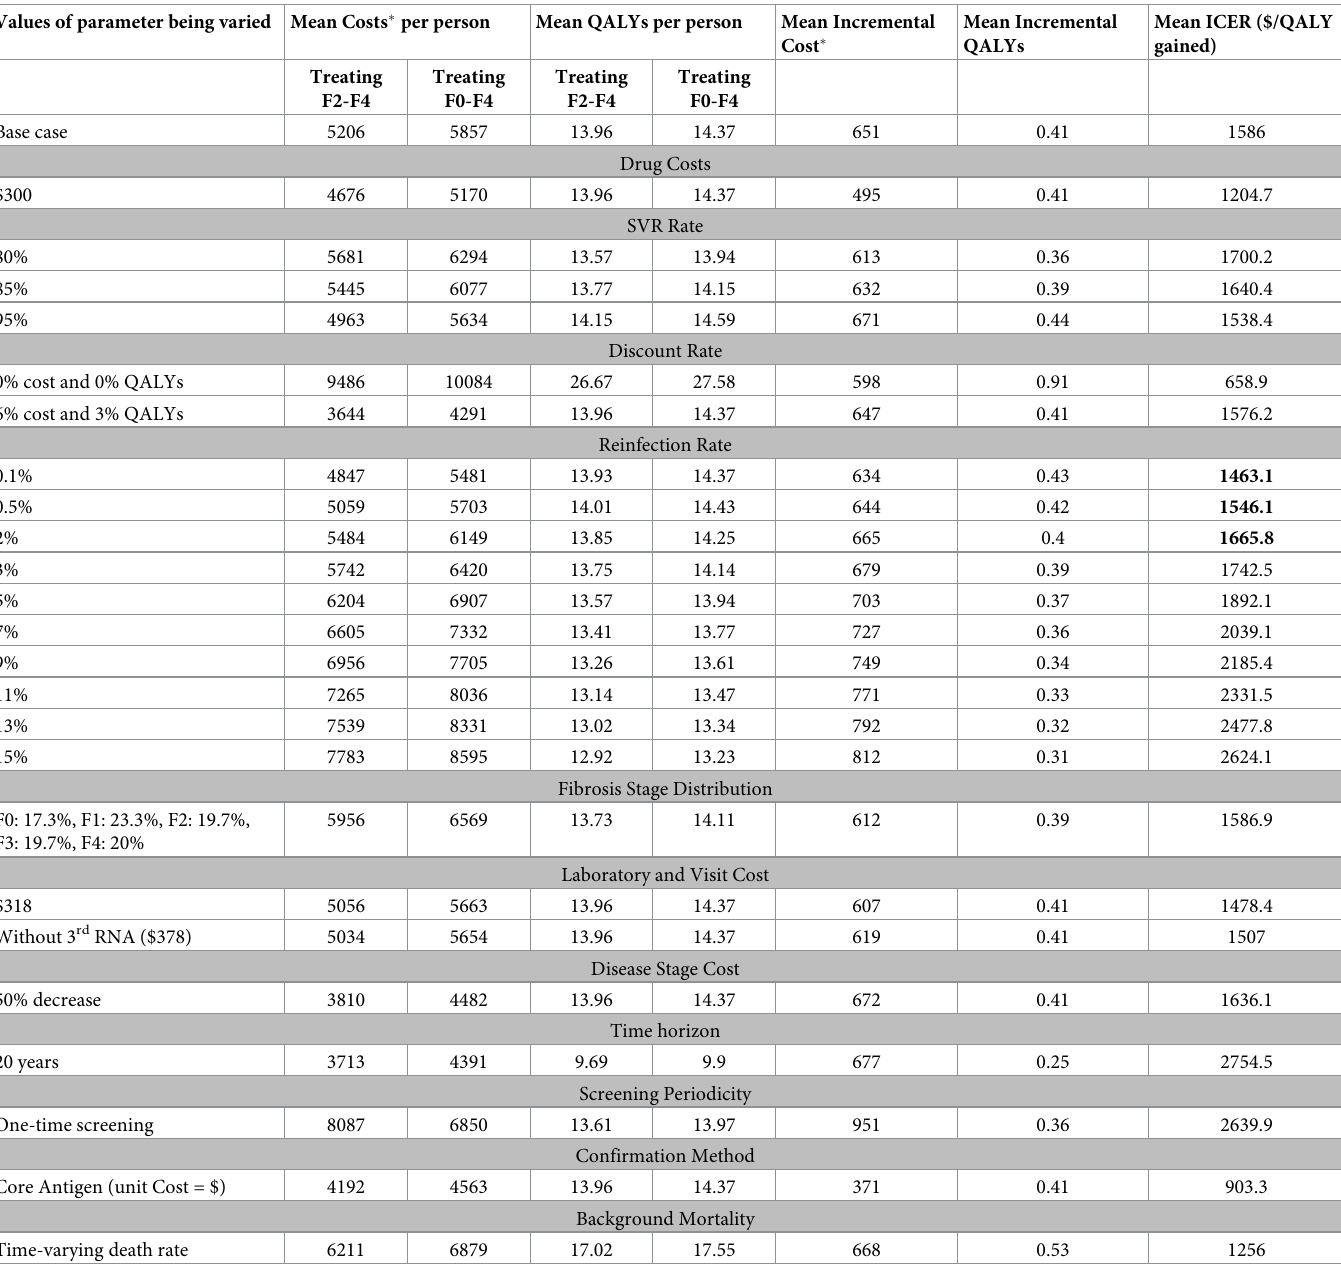
Table 2. Sensitivity analyses of cost-effectiveness results treating all diagnosed individuals (F0-F4 fibrosis) compared to targeting those with moderate-severe liver disease (F2-F4). ICER: Incremental cost-effectiveness ratio. QALY: quality adjusted life year. SVR: Sustained viral response. Values of parameter being varied Mean Costs � per